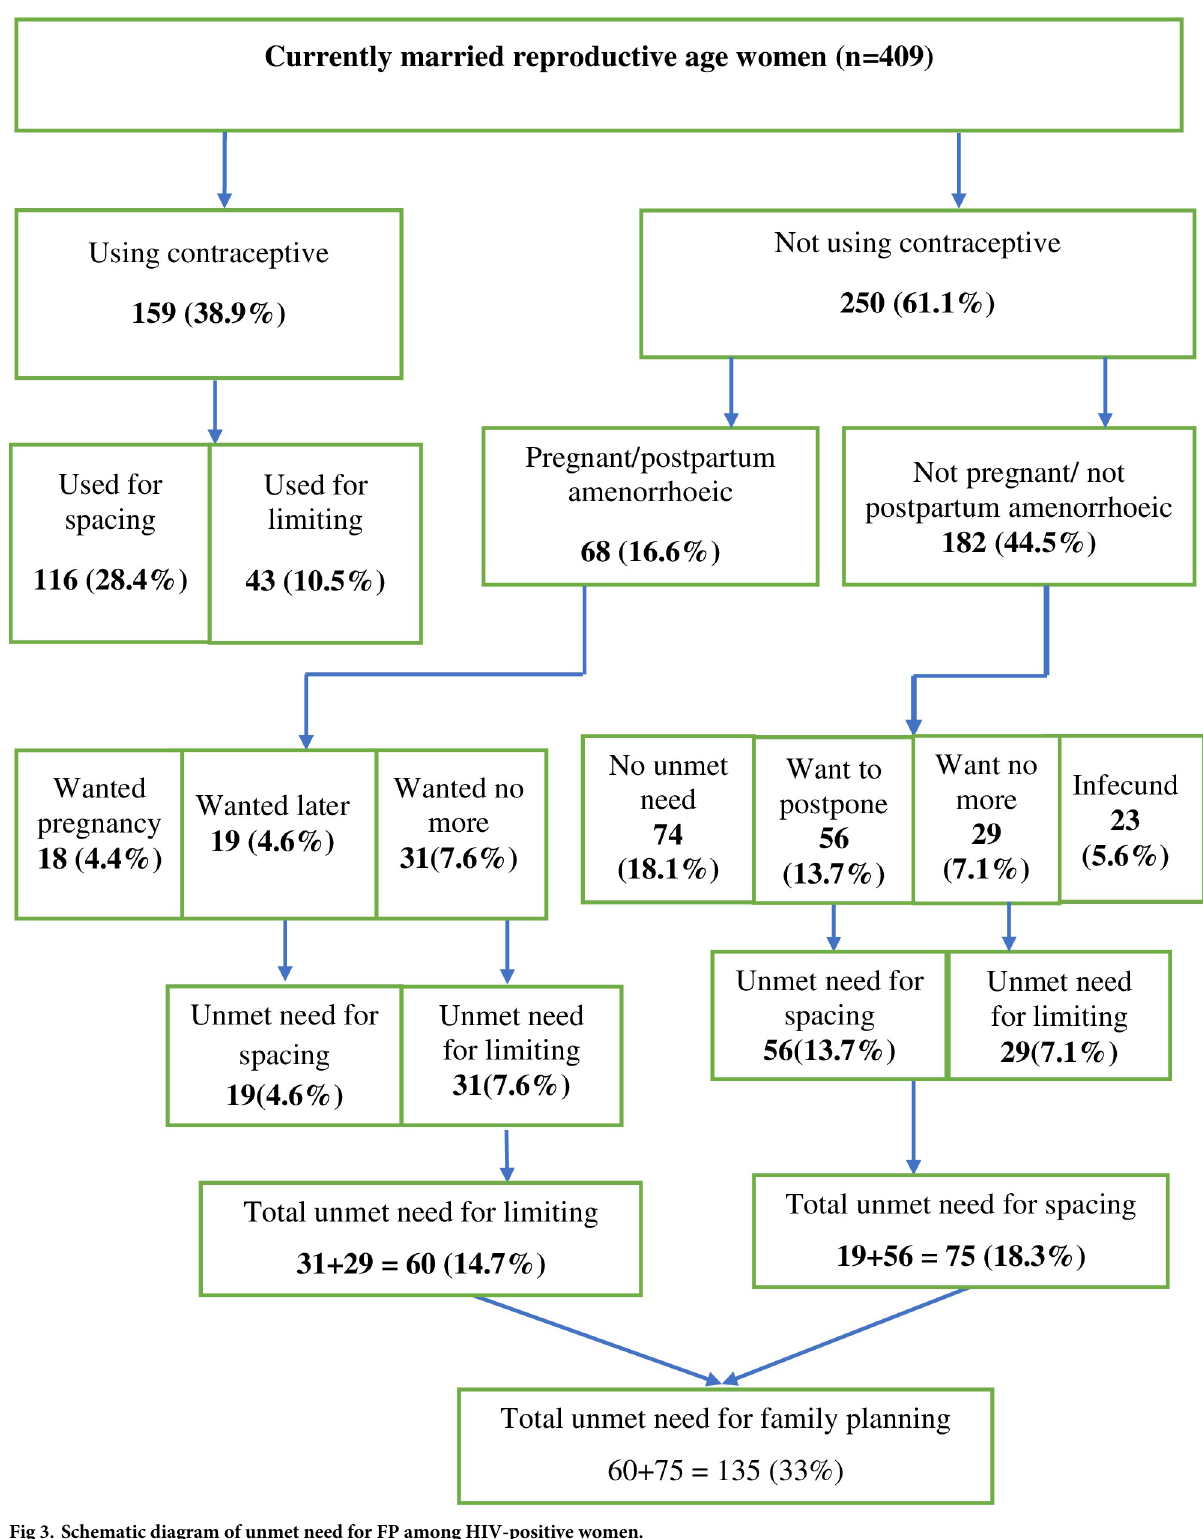
Fig 3. Schematic diagram of unmet need for FP among HIV-positive women.